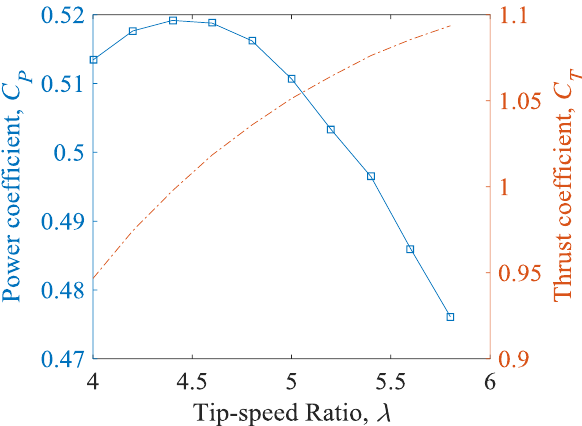
Fig. 2. Power and thrust coefficient variation over a range of tip- speed ratios. The optimum tip-speed ratio for the rotor in the present study is 𝜆 =